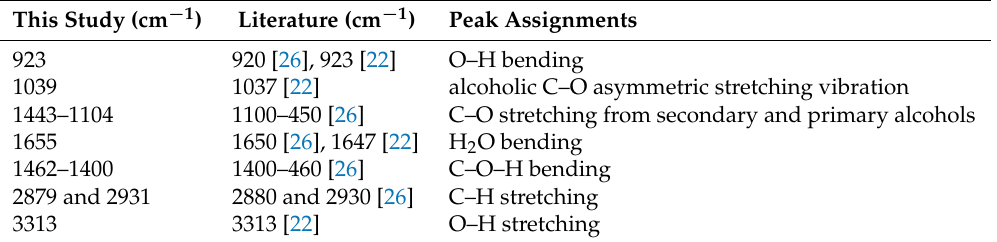
Table 1. The FTIR peaks of glycerol as UH004 P preservative agent.